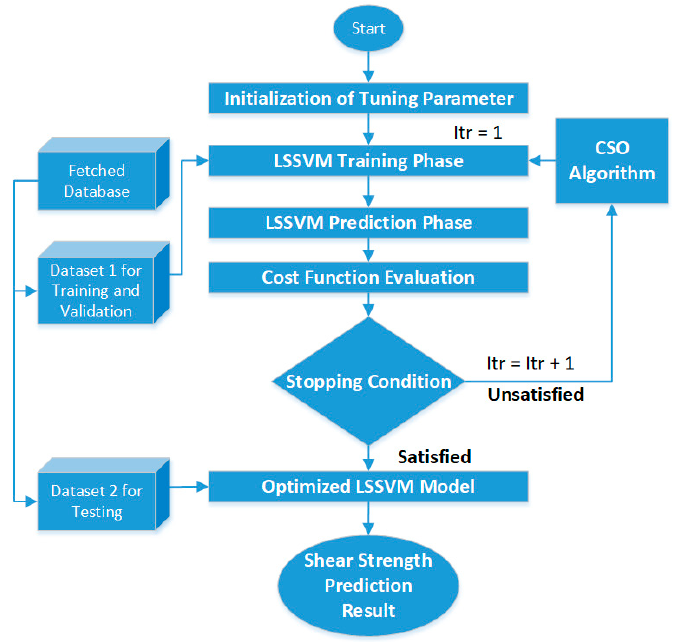
Figure 7. Working of least square support vector machine (LSSVM) model for shear strength prediction.